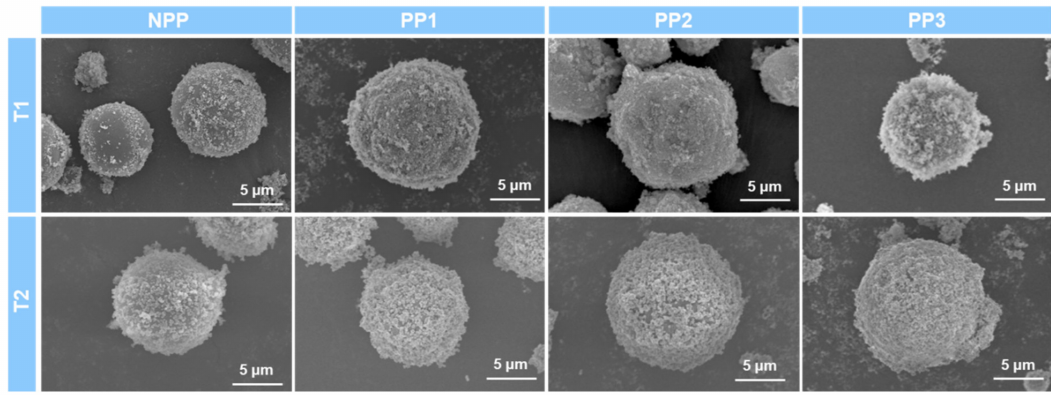
Figure 3. FE-SEM images of pure TiO 2 nanoparticles and pristine PMMA microparticles.